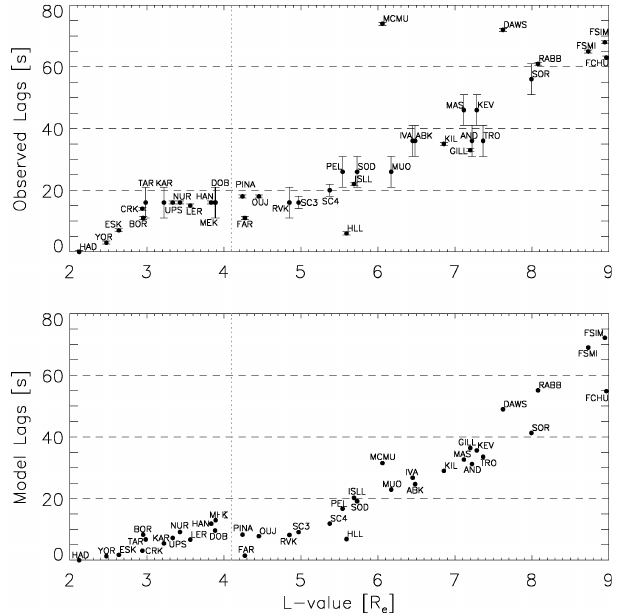
Fig. 7. Observed lag times (top panel) and relative predicted lag times (bottom panel). The dotted vertical line indicates the mod- elled plasmapause stand-off distance. The error bars in the top panel are due to the different sampling frequencies of the different mag-